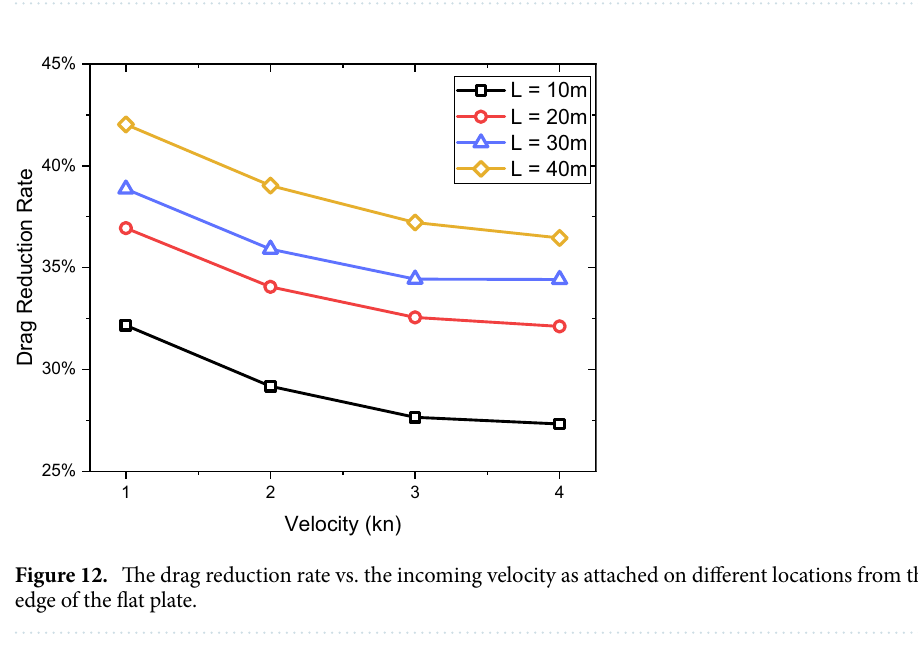
Table 5. Drag reduction rate of the remora fish swimming in the boundary layer for different flat plate lengths, velocities, boundary layer thicknesses and boundary layer to remora height ratios.